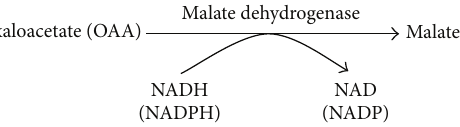
Figure 1: Schematic reaction cycle of catalyzing the conversion of oxaloacetate (OAA) to L-malate by